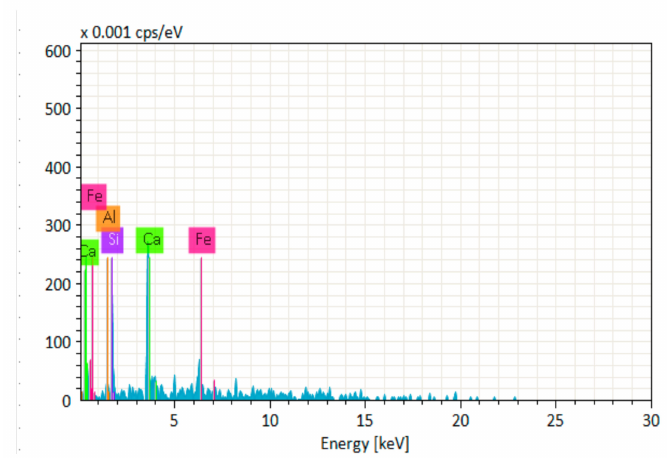
Figure 21. EDS graph of GPC-B0F mix specimen.